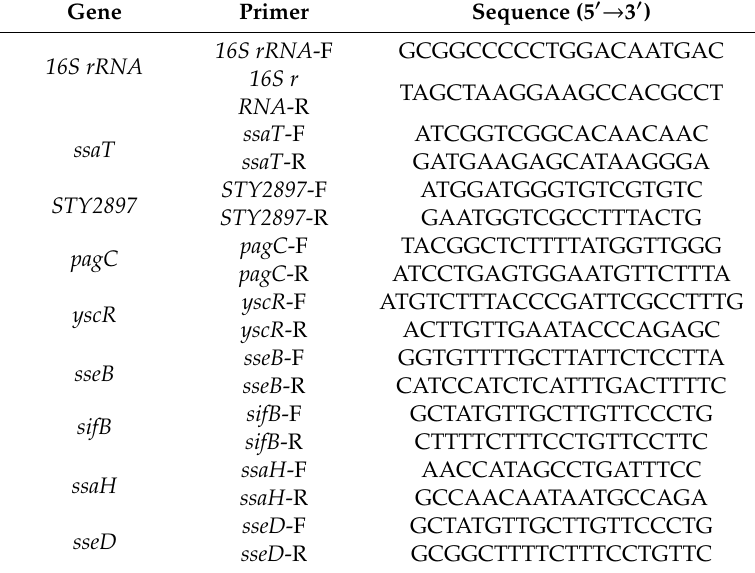
Table 3. Primers used to verify gene expression level by quantitative real-time polymerase chain reaction